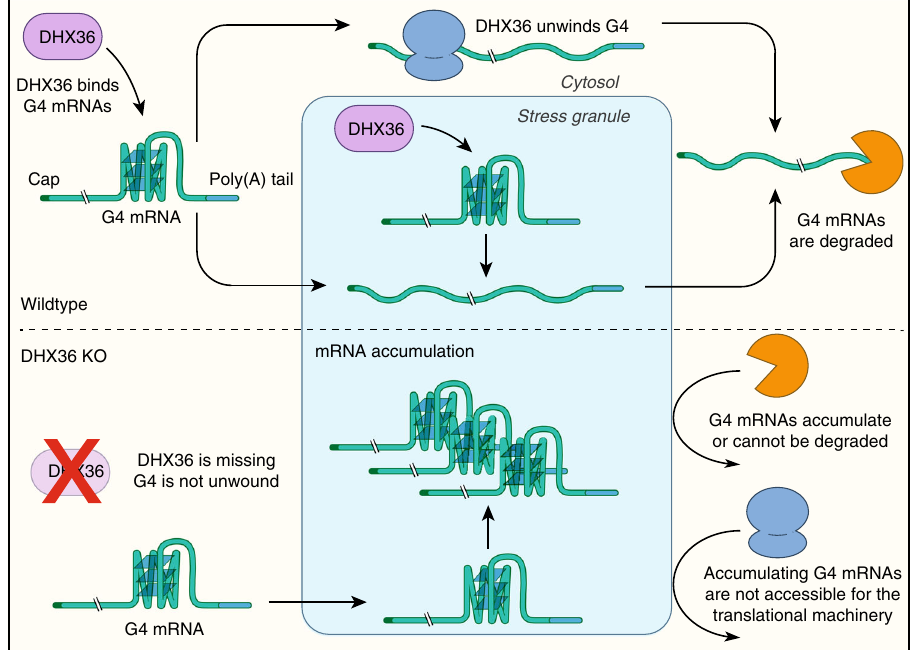
Fig. 8 Schematic of our model of DHX36 function. DHX36 helps unwind G4 structures forming in the 3 ′ UTR of mRNA and thus prevents their accumulation in SG and/or helps releasing them from these structures. In DHX36-KO cells, G4 containing mRNA cannot be translated and accumulate in